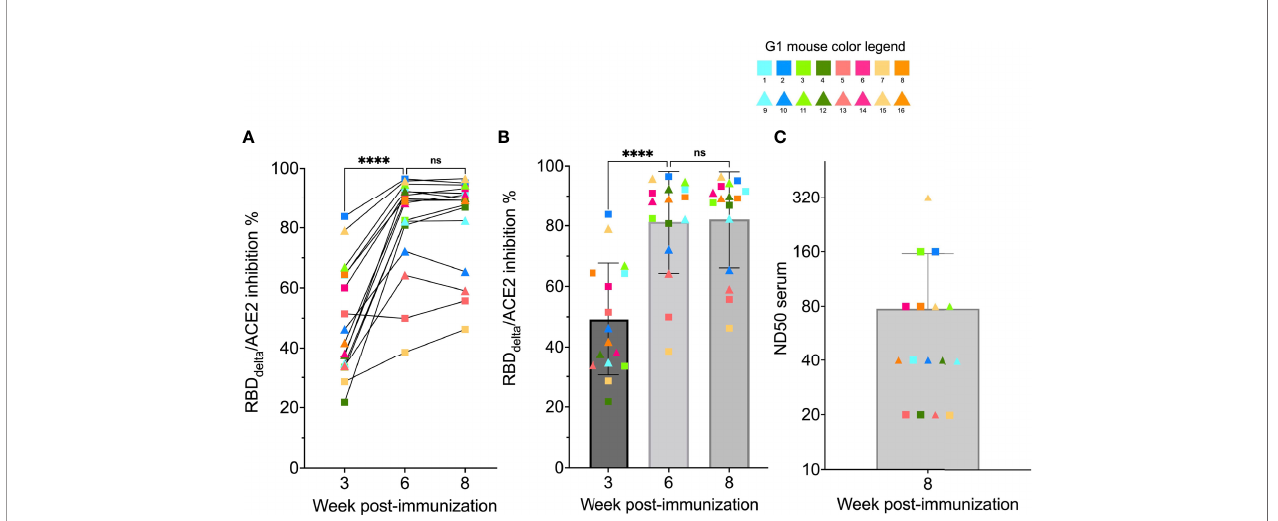
FIGURE 5 | RBD Delta -ACE2 interaction inhibition by neutralizing antibodies and SARS-CoV-2 Delta variant neutralization in K18-hACE2 transgenic mice: Sera samples of immunized K18-hACE2 transgenic female mice (n= 16) analyzed with the SARS-CoV-2 neutralization antibody assay and the SARS-CoV-2 Delta variant neutralization test (Group 1 with individual color code, squares indicate mice euthanized at 3 dpi and triangles indicate mice followed until 14 dpi). (A) RBD Delta -ACE2 interaction inhibition rate at week 3, 6 and 8 with paired individual values. (B) RBD Delta -ACE2 interaction inhibition rate at week 3, 6 and 8. Week 3 and 6 were signi fi cantly different in one-way ANOVA multiple comparison ( p -value< 0.0001). Week 6 and 8 were not signi fi cantly different ( p -value= 0.66). (C) Median neutralization dose (ND50) at week 8. ns, not signi fi cant, ****p ≤ 0.0001.